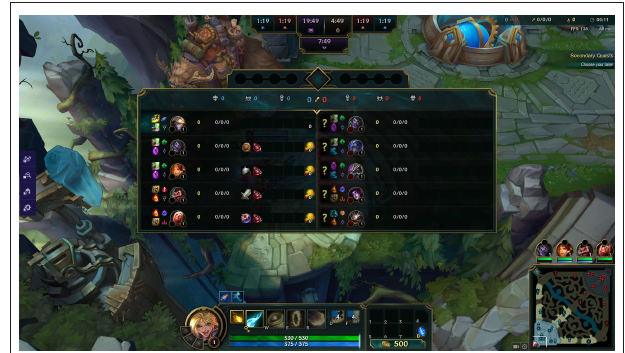
FIGURE 3 | The League of Legends in-game UI presents information about player performance including kill counts, gold, experience earned, and creeps killed while playing the game. Image reproduced with permission from Riot Games Inc. This image is copyrighted to Riot Games